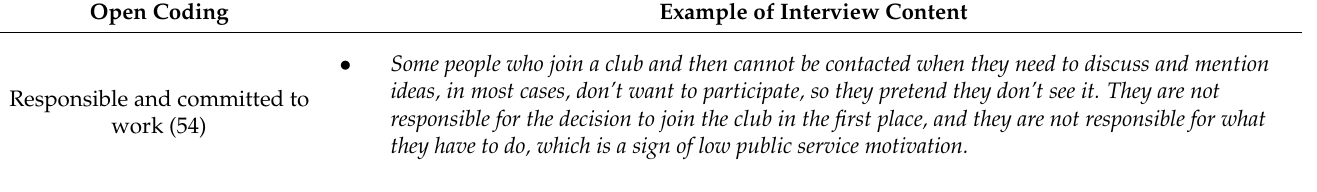
Table 3. Material information for the “Commitment to the public interest” sub-node of axial coding. Open